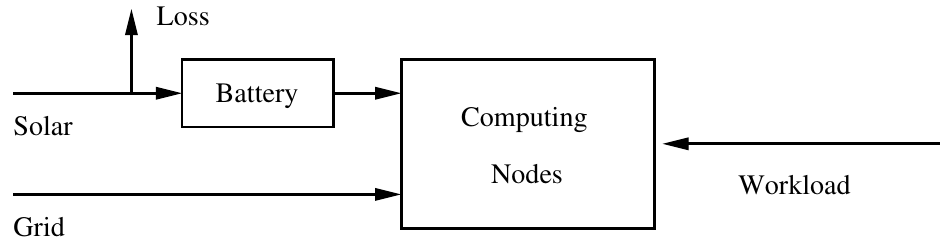
Figure 3. Principal features of the datacenter